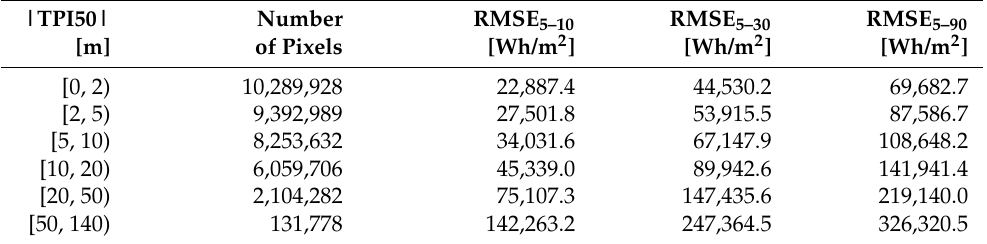
Table 5. Root mean square error (RMSE) of the potential solar radiation models calculated at a resolution lower than 5 m in relation to absolute values of TPI50 (TPI calculated with a circular neighbourhood of 50